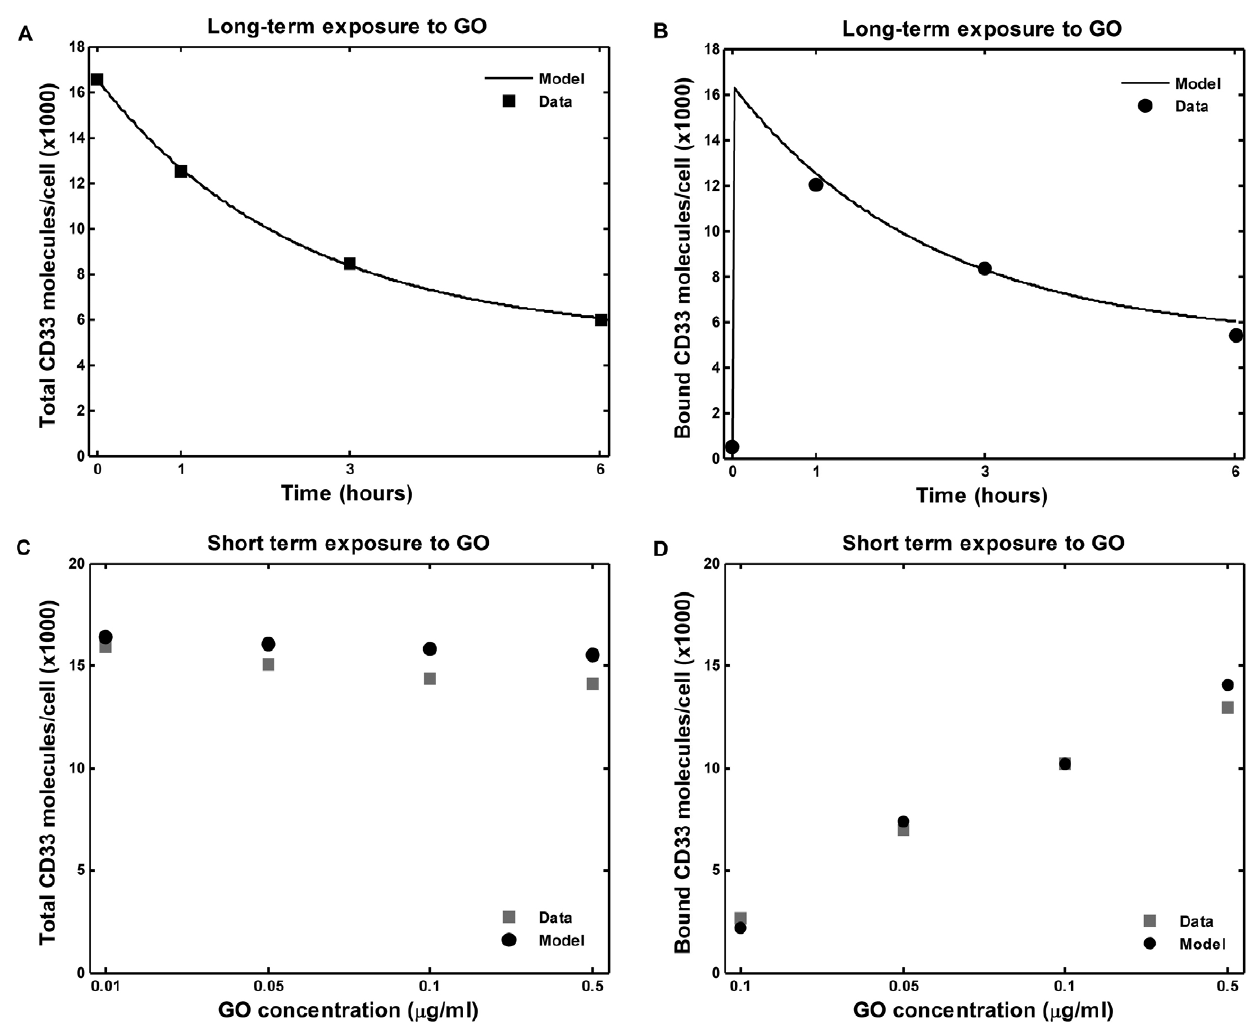
Figure 1. Estimation of the model parameters from in vitro experiments. Model parameters were estimated by fitting model equations to the data of in vitro interaction of GO with AML193 cells. AML193 cells were exposed continuously to either saturating GO concentration (5 m g/ml) for 1, 3, and 6 hours, or to non-saturating GO concentrations (0.1 to 0.5 m g/ml) for 15 minutes. In saturating experiments measured amounts of total ( A ) and bound ( B ) CD33 molecules per cell were fitted by equation (3); CD33 production rate (R p ), free (k e ) and bound CD33 internalization rates were estimated. In non-saturating experiments measured amounts of total ( C ) and bound ( D ) CD33 molecules per cell were fitted by equations (1); estimated parameters were drug-CD33 association (k b ) and dissociation (k u ) rates (R p , k e and k i were set to their values obtained from the saturating experiments). Fitting was performed to the results of single representative experiments.